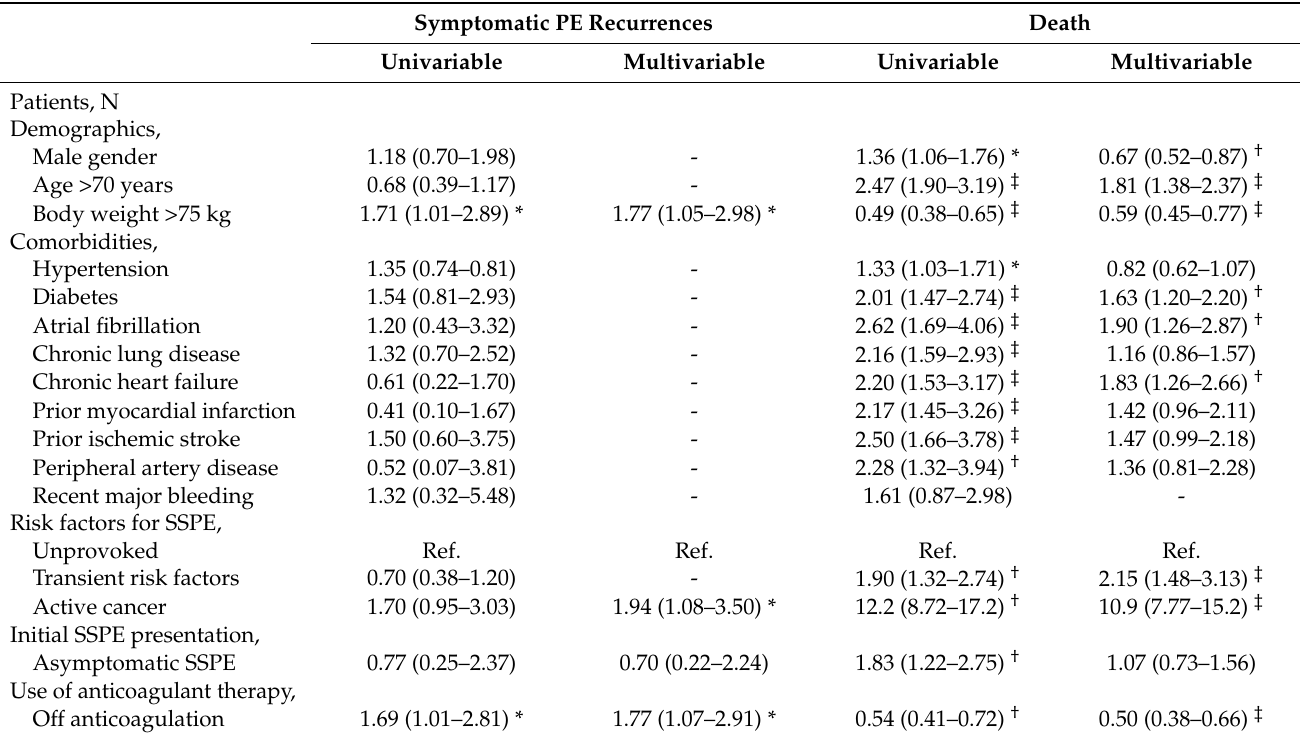
Table 6. Uni- and multivariable analyses for recurrent PE (using competing risk analysis for death) and for all-cause death during follow-up (either during anticoagulation or after its discontinuation). Symptomatic PE Recurrences Death Univariable Multivariable Univariable